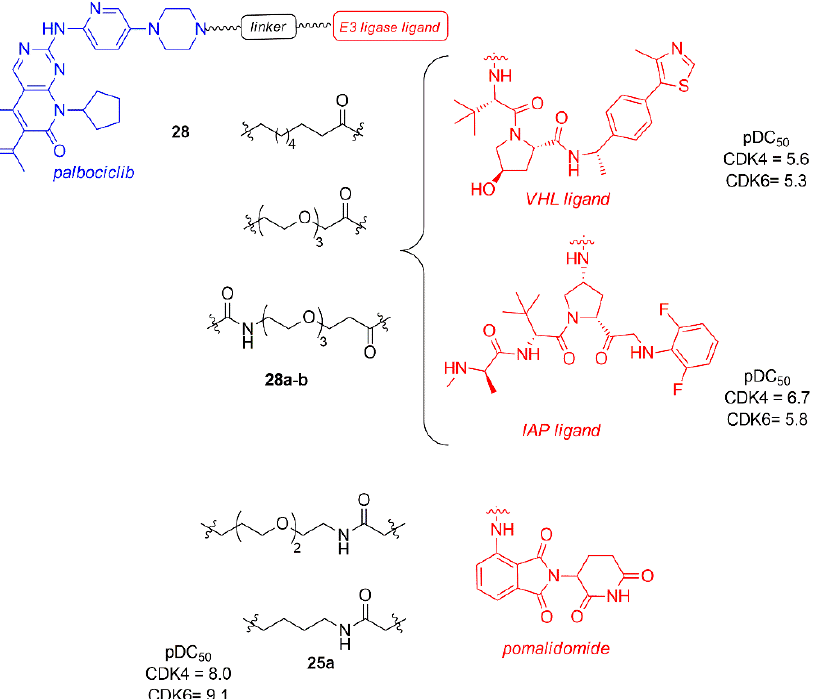
Figure 17. PROTACs palbociclib and E3 ligase ligands, such as von Hippel-Lindau (VHL) and Inhibitor of Apoptosis (IAP) ligands and pomalidomide.